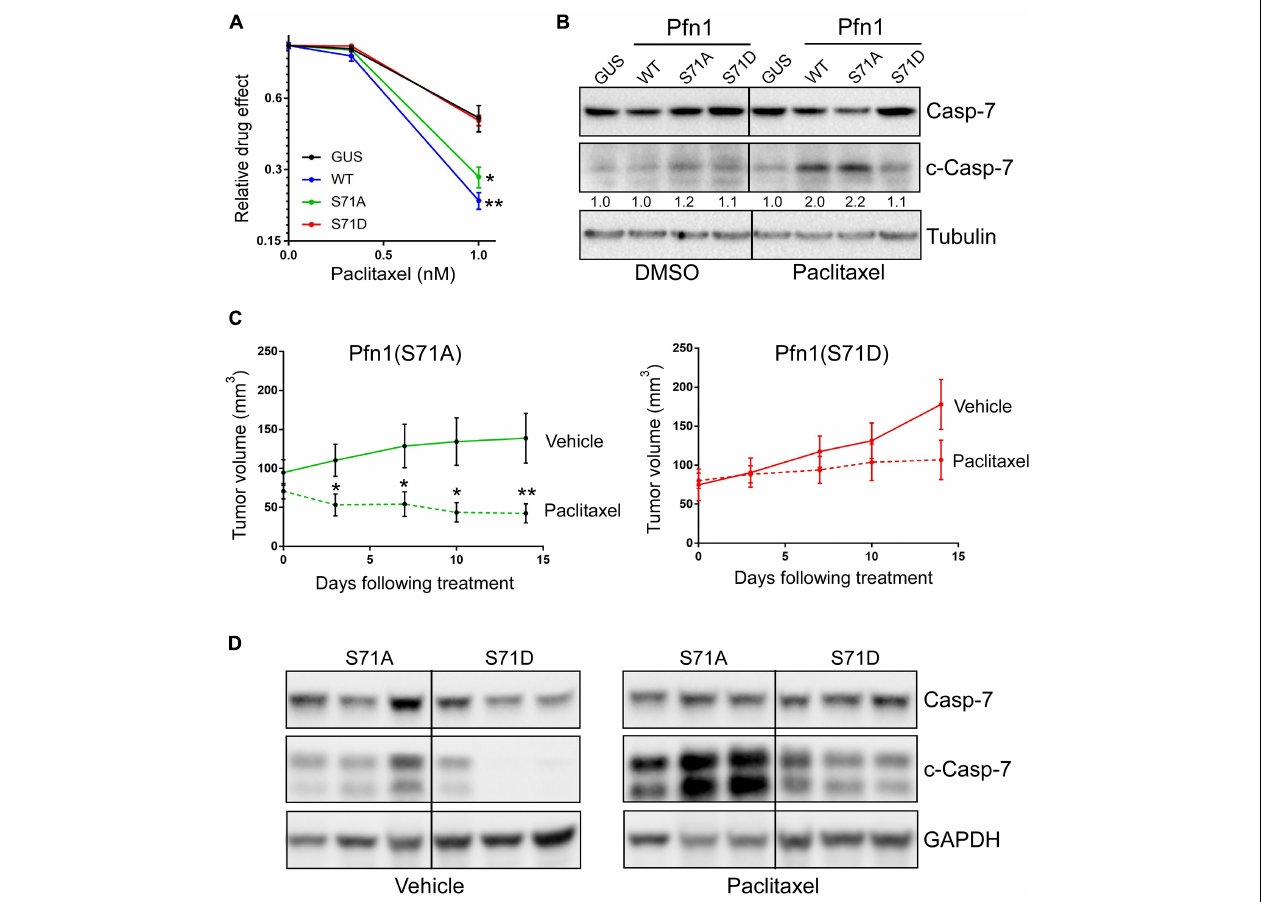
FIGURE 5 | Ser 71 phosphorylation abolishes the pro-apoptotic activity of Pfn1 in response to paclitaxel. (A) Stable MDA-MB-231 cells were seeded in 96-well plates and treated with DMSO or paclitaxel for 7 days. Relative drug effects were calculated by normalizing Alamar blue values of drug-treated cells by DMSO-treated cells. Data are mean ± SEM of four technical replicates in one experiment. Similar results were observed in three independent experiments. P -values were based on two-tailed unpaired t -test (versus GUS control). (B) Stable MDA-MB-231 cells were treated with DMSO or 5 nM paclitaxel for 48 h, followed by Western blot analysis for full-length or cleaved caspase-7 or tubulin. Cleaved caspase-7 levels were quantified by densitometry and normalized by the levels in GUS control cells in DMSO or paclitaxel groups. (C) MDA-MB-231 stable cells expressing Pfn1(S71A) or Pfn1(S71D) were injected bilaterally into the 4th mammary fat pads of female nude mice (10 mice per group). Tumor-bearing mice were evenly divided and treated with vehicle (0.9% sodium chloride) or paclitaxel (10 mg/kg) by intraperitoneal injection for 2 weeks. Tumor volumes were measured semiweekly by Caliper. Data are mean ± SEM. P -values were based on two-tailed unpaired t -test between vehicle and paclitaxel treatment groups at individual time points. * p < 0.05; ** p < 0.01. (D) Randomly selected tumors harvested from vehicle or paclitaxel-treated mice in (C) were blotted for full-length or cleaved caspase-7 and GAPDH. Each tumor was from a different